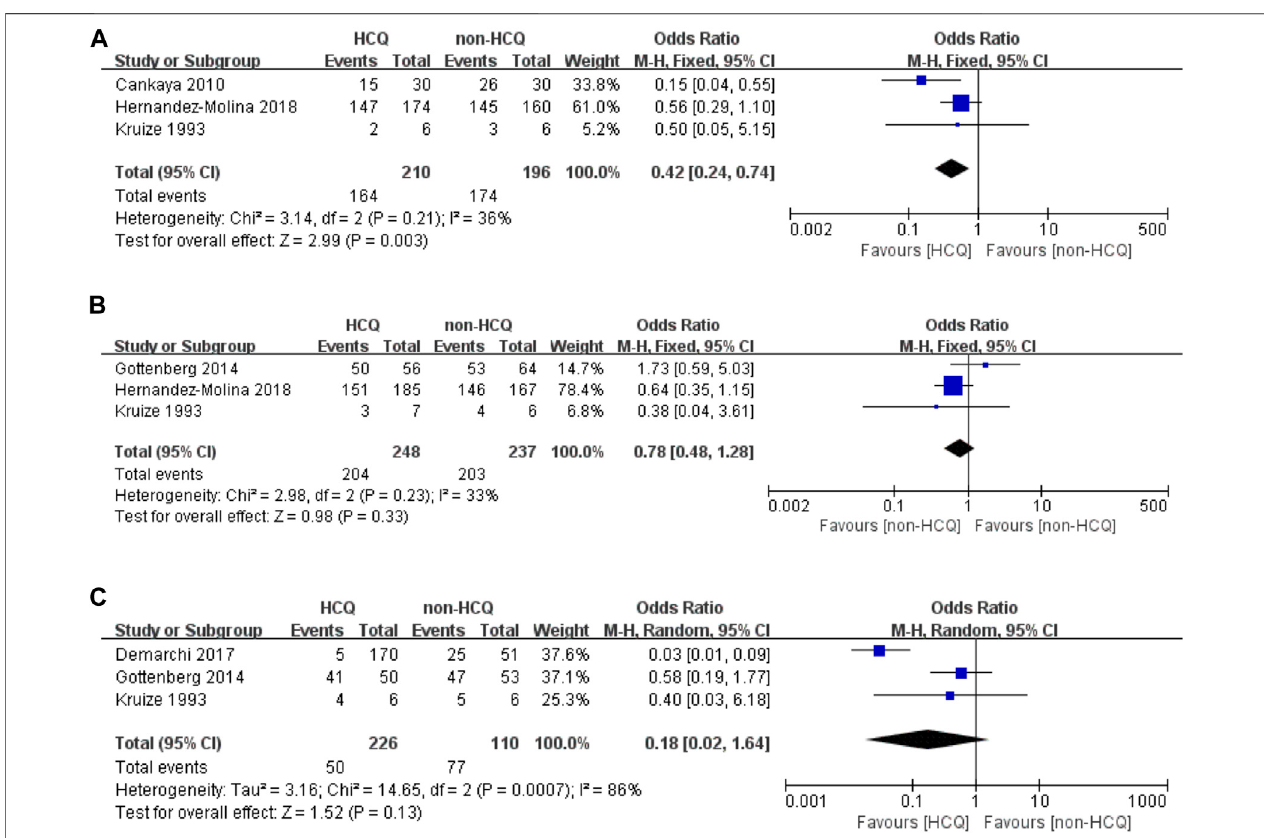
FIGURE2| Forest plotofstudiescomparingHCQ groupandthenon-HCQgroup, examiningtheeffectonpSS(includingoraldomain, oculardomain andfatigue). (A) oral domain. (B) ocular domain. (C) fatigue.